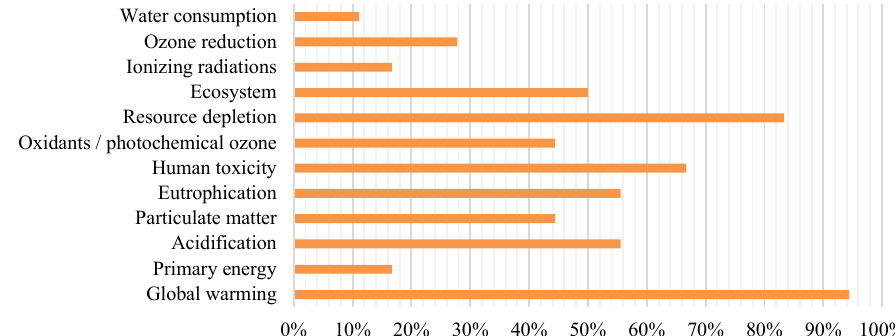
0% 10% 20% 30% 40% 50% 60% 70% 80% 90% Fig. 2. Graphical representation of the percentage of incidence of the impact categories considered by the studies analysed in this article.